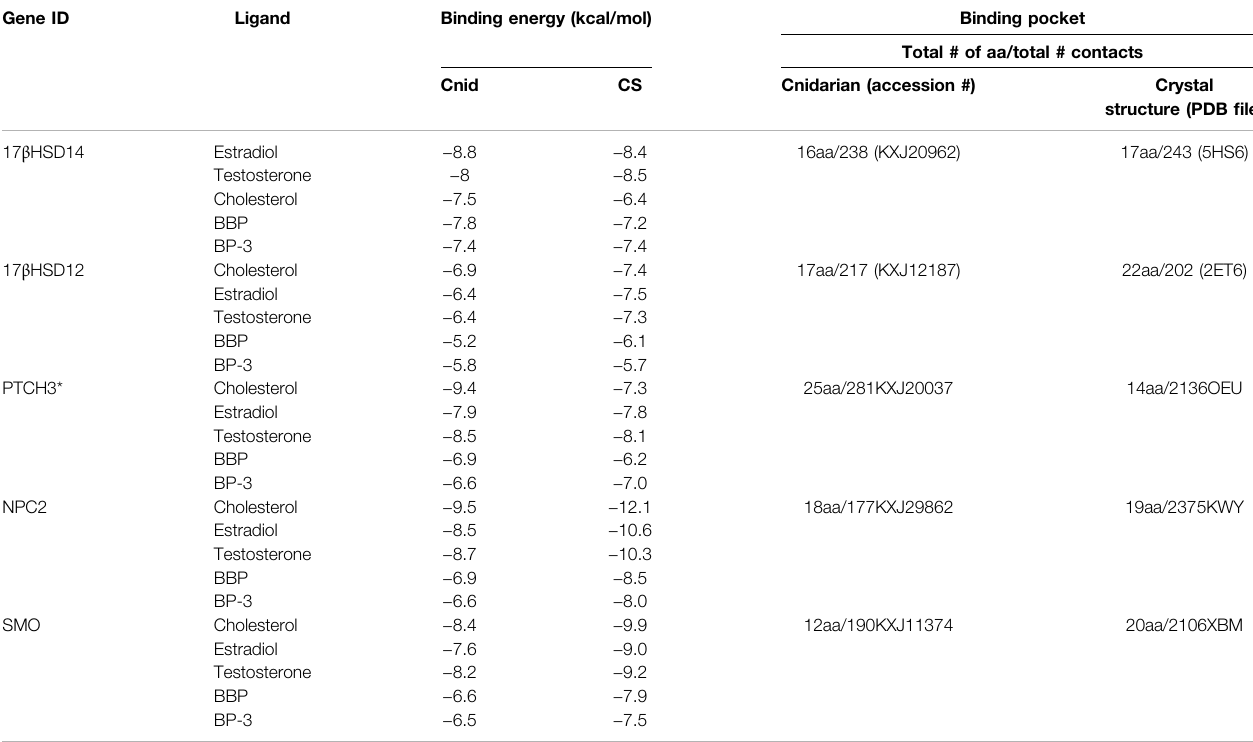
TABLE 2 | Binding af fi nities (in kcal/mol) of ligands to proteins, estimated by docking simulations. Values represent the lowest energy binding mode for each docking experiment. Cnid: cnidarian; CS: crystal structure. Total number of amino acids and the total number of physical contacts represent binding pocket interactions. * indicates no direct homolog for PTCH3 so PTCH1 PDB fi le (6OEU) was